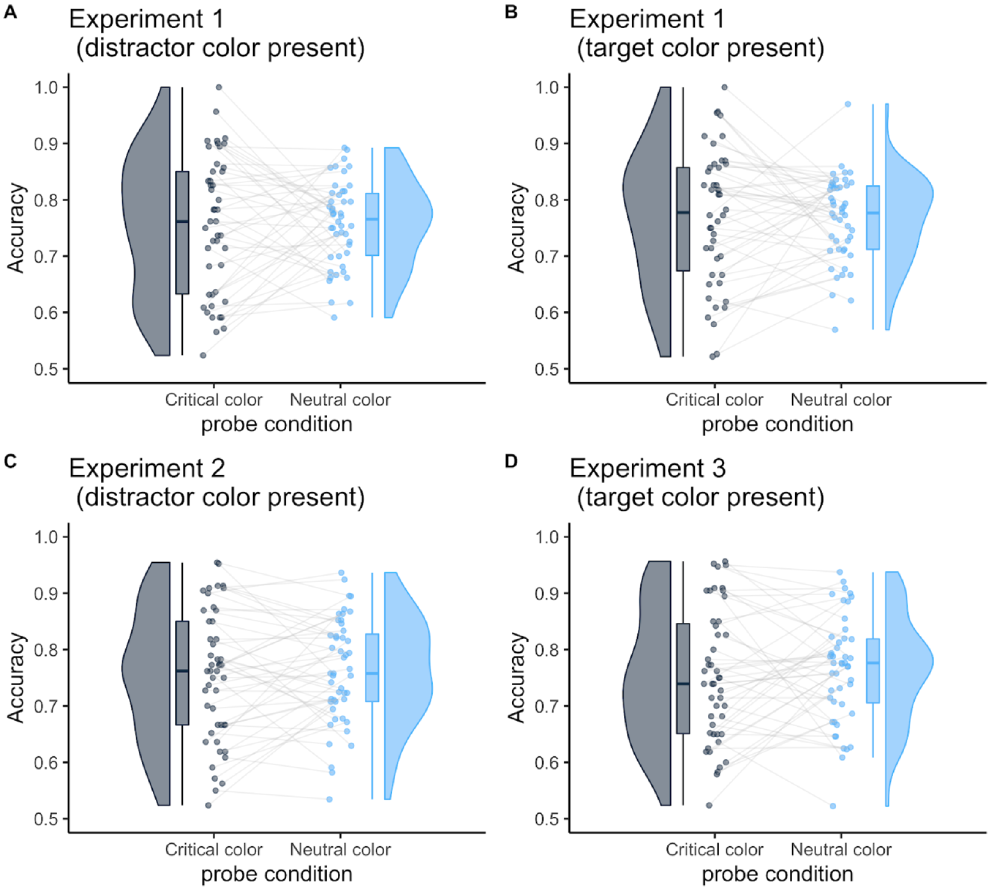
Figure 4. Mean accuracy in the probe task as a function of probe-target color. The probe-target color was either the critical color or neutral color. The critical color was either the distractor or the target color in Experiment 1; it